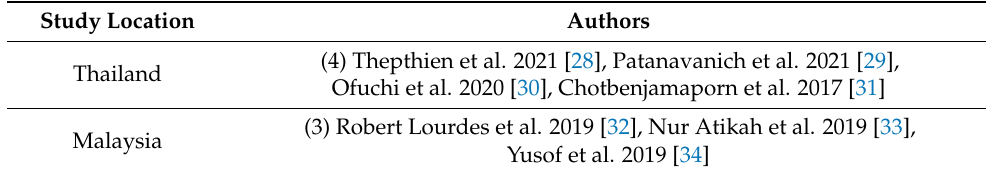
Table 2. Summary of study location and